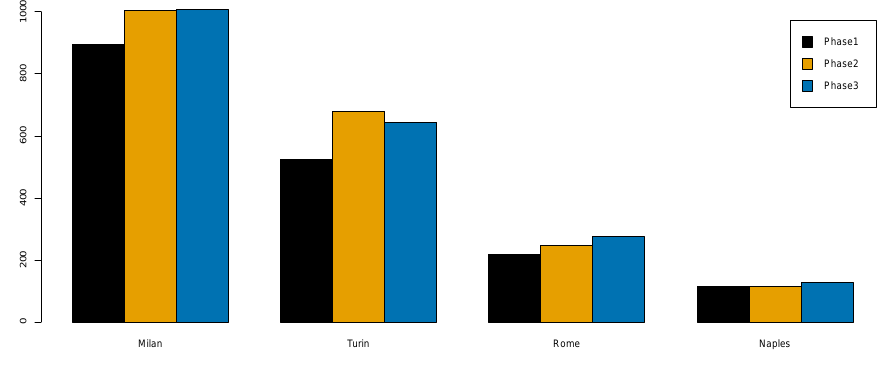
Figure 5. Top province-specific estimated risk for the three